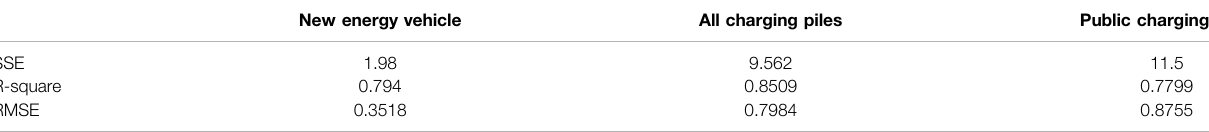
TABLE 4 | Parameters of power law distributions.